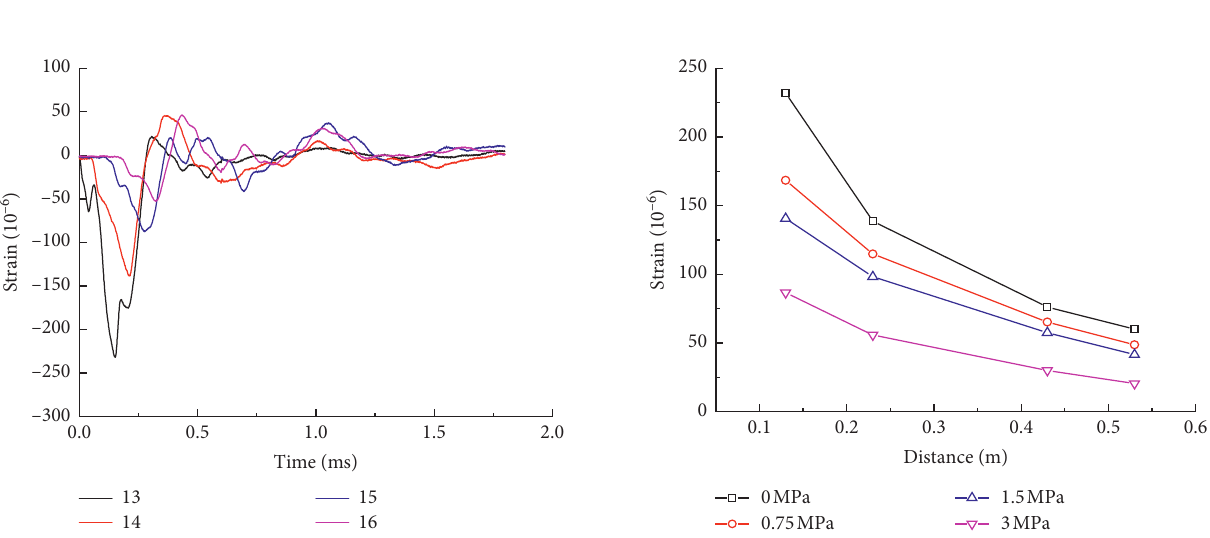
Figure 18: Attenuation law of the cylindrical stress wave in the intact rock mass under different confining